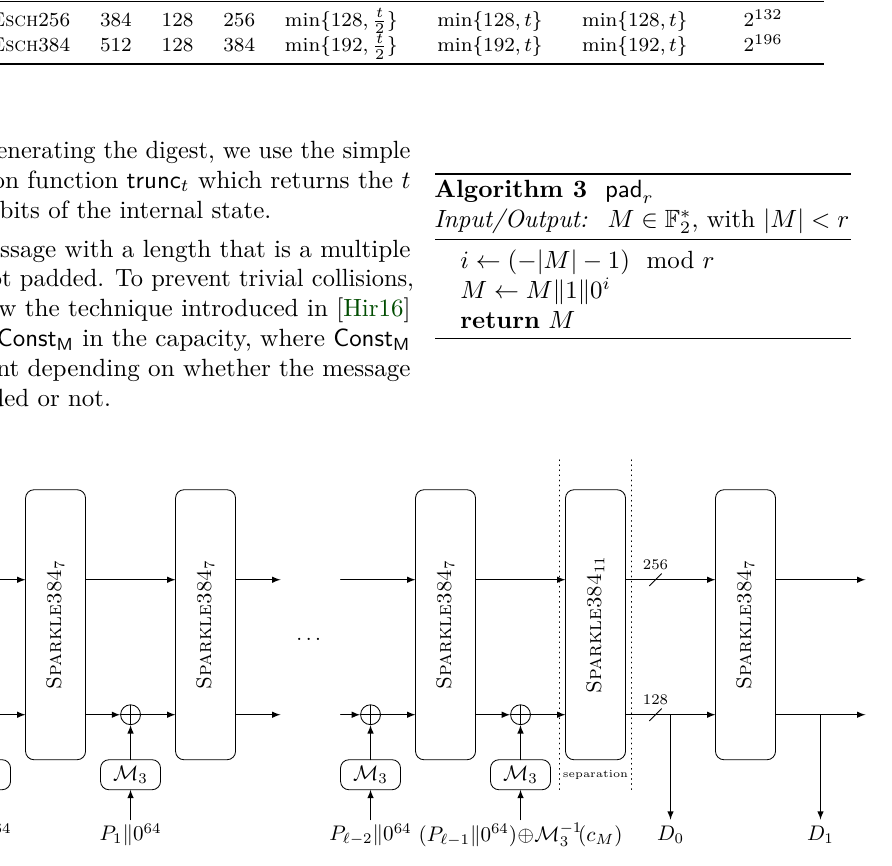
Figure 3: Esch 256 with rate 𝑟 = 128 and capacity 𝑐 = 256. The constant 𝑐 (0 , 0 , . . . , 0 , 1) ∈ F 192